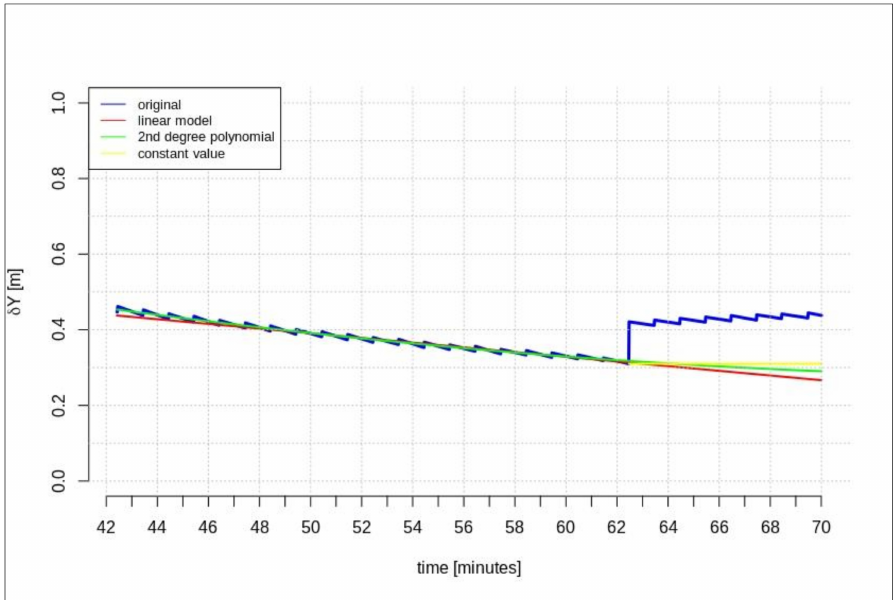
Figure 9. The results of the δ Y geocentric correction extrapolation (GPS G13) for a 15 min data-stream—The time series of the orbit corrections refer to an out-of-date navigation message.